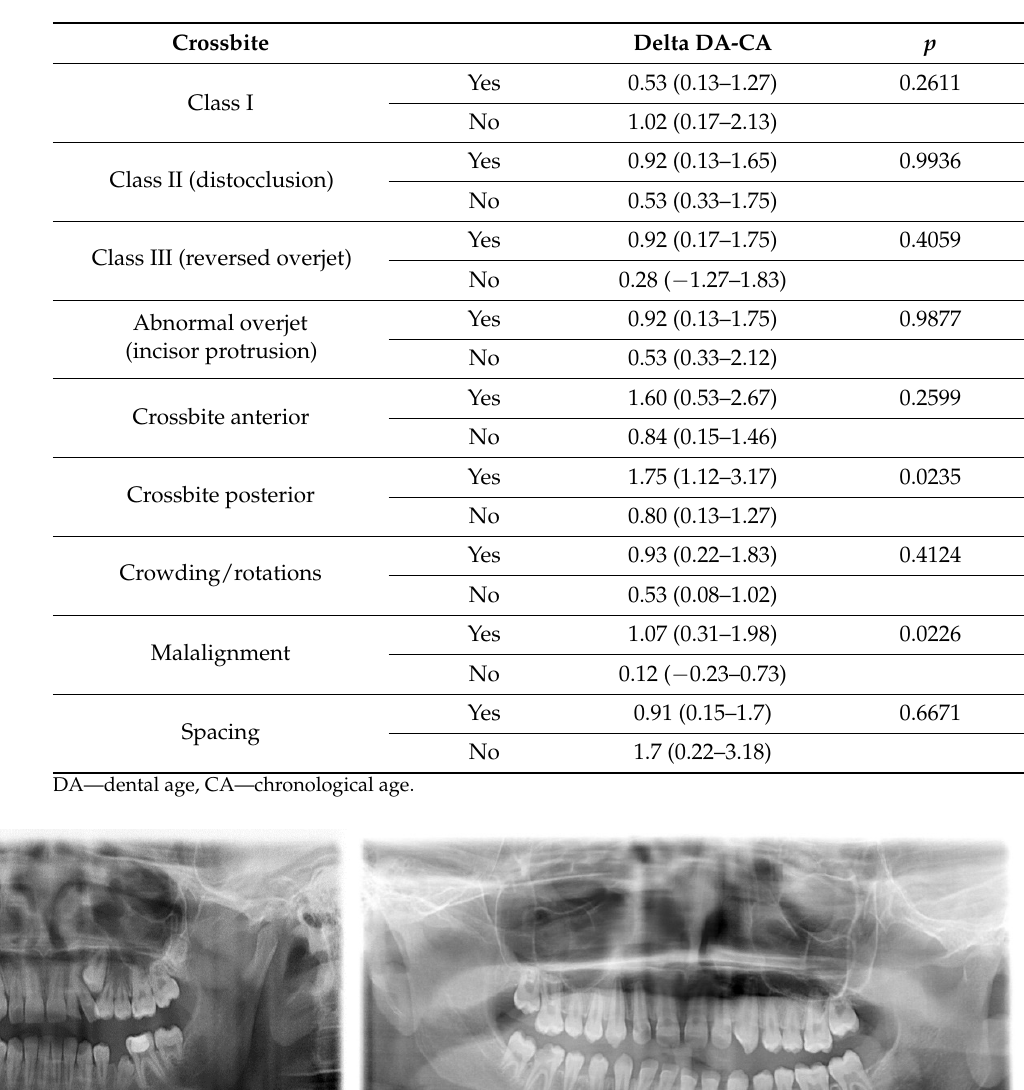
Table 4. Comparison of dental age (DA-CA) among cancer patients with different types of dental occlusion.